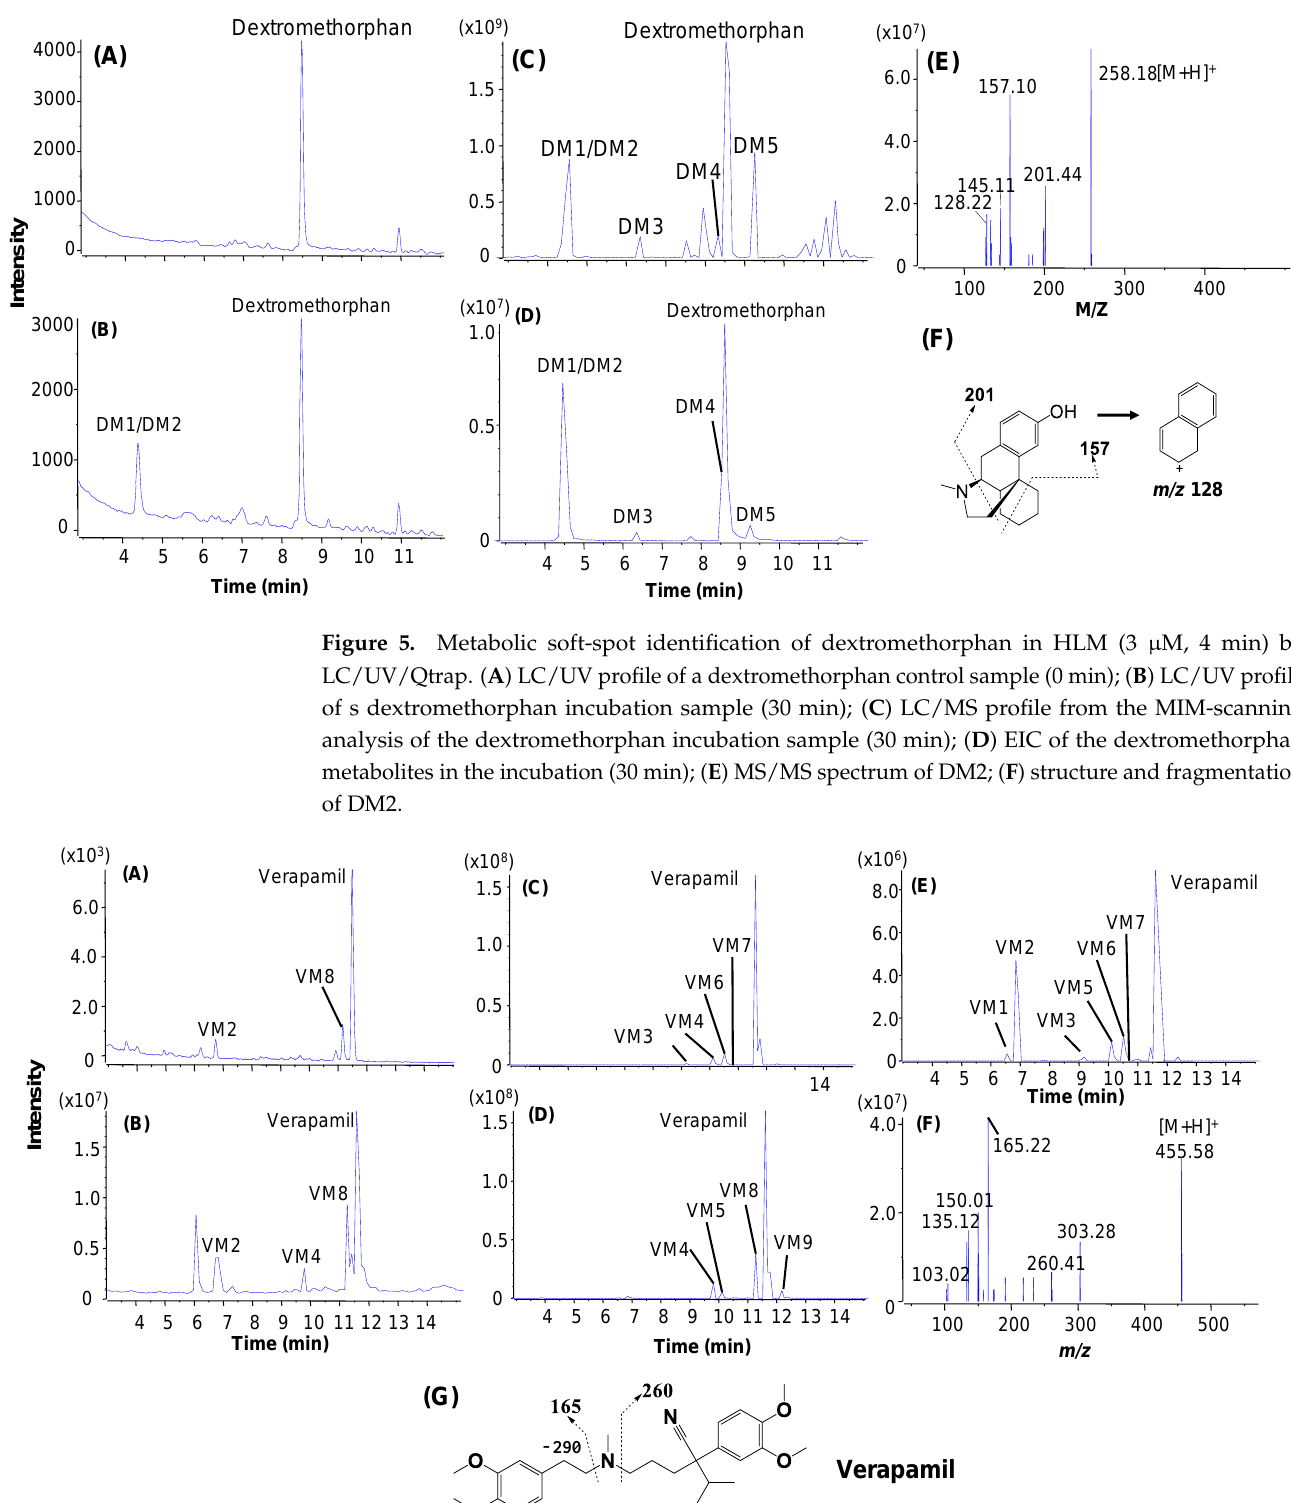
Figure 7. Metabolic soft-spot identification of midazolam in HLM (3 µM, 2 min) and amodiaquine (3 µM, 1 min) by LC/UV/Qtrap. ( A ) LC/UV profile of the midazolam incubation sample; ( B ) LC/MS profile of the MIM scanning of the midazolam incubation sample; ( C ) LC/UV profile of the amodi- aquine incubation sample; ( D ) LC/MS profile of MIM scanning of the amodiaquine incubation sam- ple; ( E ) MS2 spectrum of the major metabolite of midazolam (MM2); ( F ) MS2 spectrum of the major